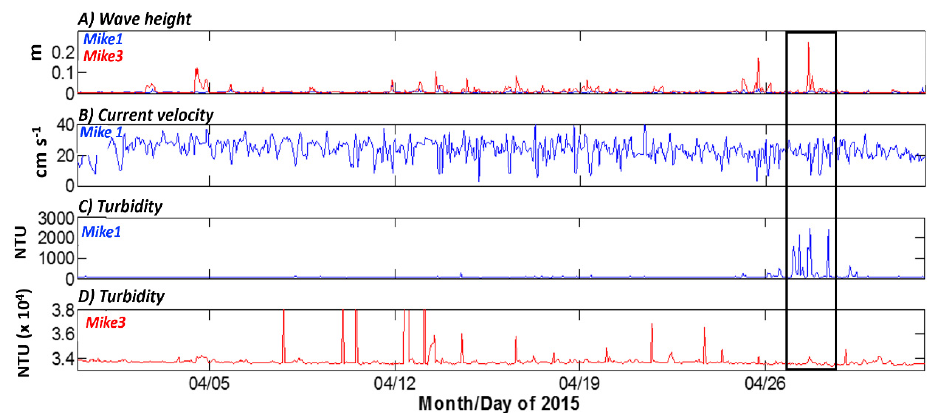
Figure 4. Hydrological variables and turbidity variations, measured in nephelometric turbidity unit- NTU, ( A – D ) at monitoring stations located in Mike Island (Wax Lake Delta, LA, USA) during instrument deployment in April 2015; note the enhanced wave height at Mike3 and turbidity at Mike1 during late April (rectangle inset). See the methods section for the instruments’ description.